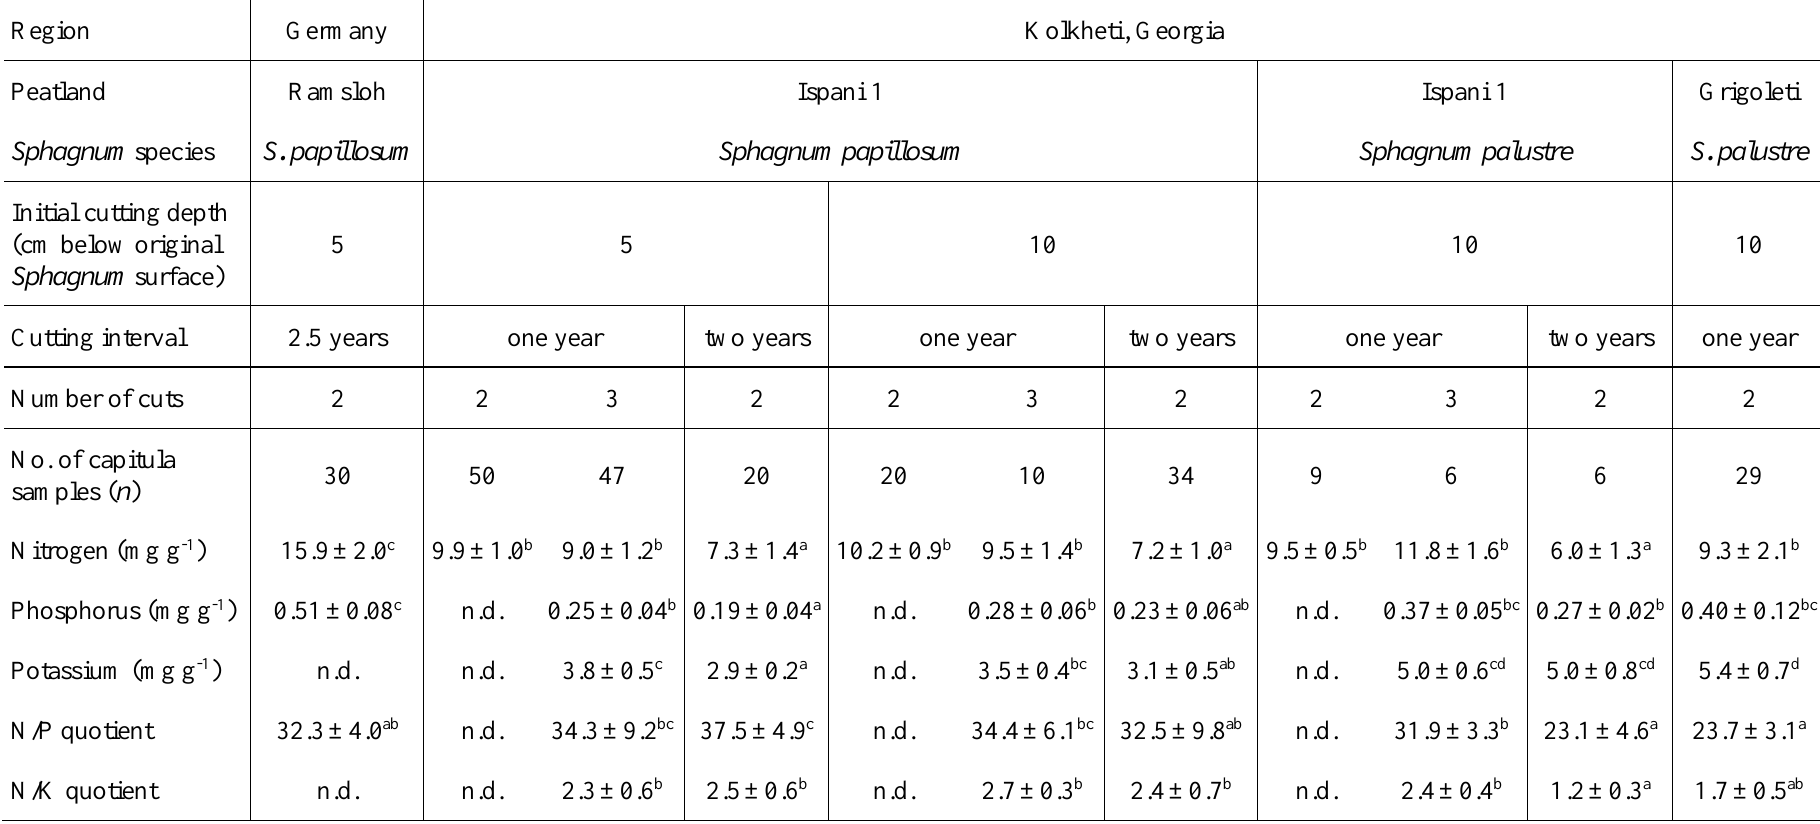
Table A2. Sphagnum capitula element concentration (dry mass basis) after cutting (N, P and K, mean values with standard deviation) in the various treatments for the study periods Apr 2007–Mar 2009 (Ispani 1), Apr 2008–Mar 2009 (Grigoleti) and Aug 2008–Mar 2011 (Ramsloh). Values with different superscripts (a–d) differ significantly ( P ≤ 0.05); n.d. = not determined. Differences between treatments were analysed using the non-parametric Kruskal Wallis test after Siegel & Castellan (1988), following a significant overall Kruskal Wallis test for each variable ( P -value < 0.001) - Nitrogen: χ 2 = 157.96; Phosphorus: χ 2 = 87.07; Potassium: χ 2 =